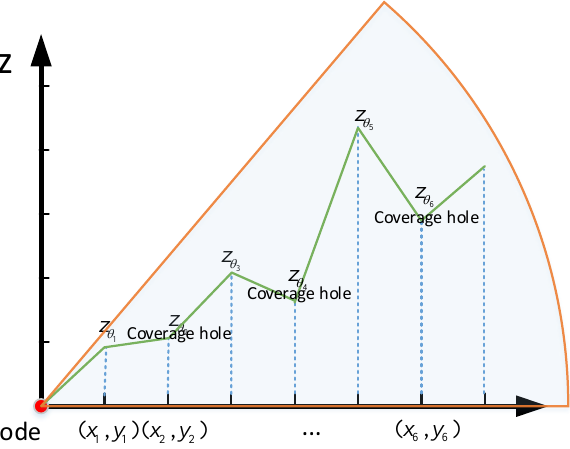
Figure 5. Elevation value point coverage criterion in the direction of node perception.